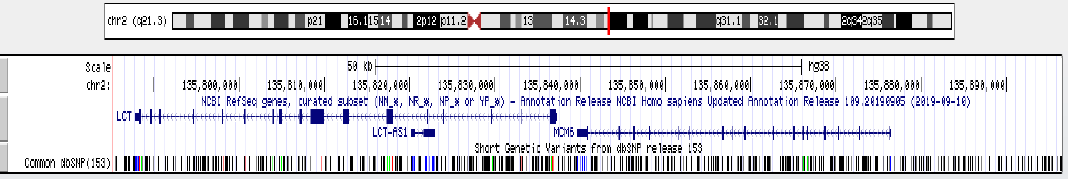
Figure 1. Genomic region 2q21 containing the LCT and MCM6 loci (capture from the University of California, Santa Cruz (UCSC) Genome Browser). Exons are represented with boxes and introns with lines. This capture also includes information for all the known single nucleotide polymorphisms (SNPs) mapping the region, according to the dbSNP v153.